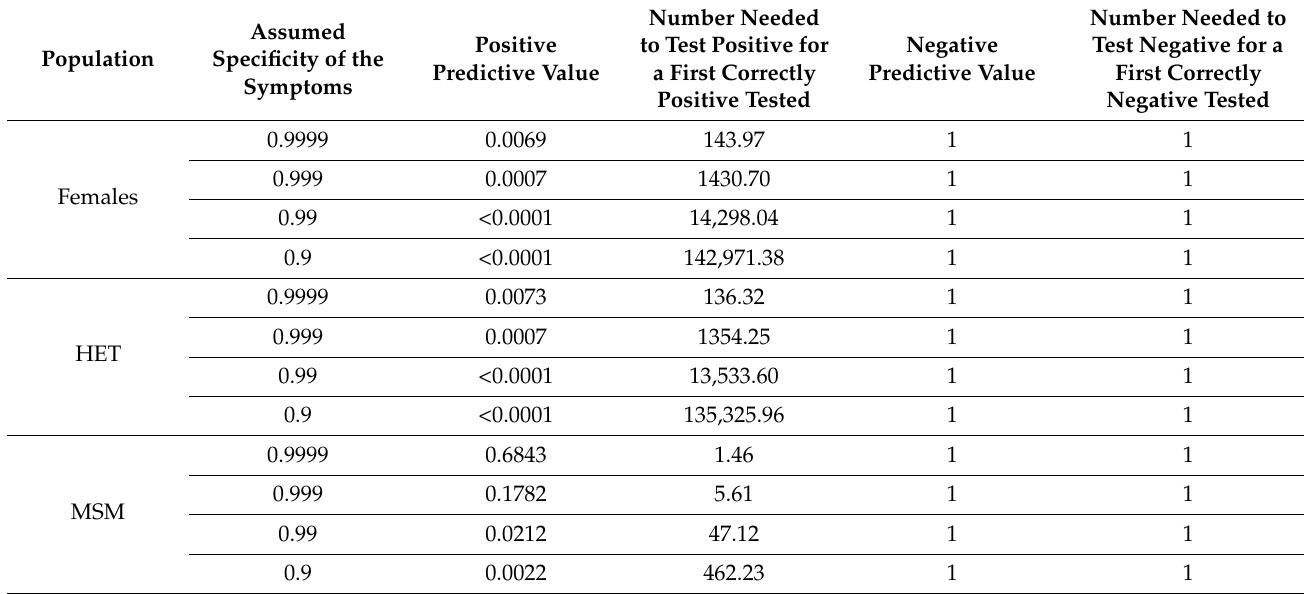
Table 4. Positive and negative predictive values of the symptoms component of the case definition depending on various assumed specificity rates until day